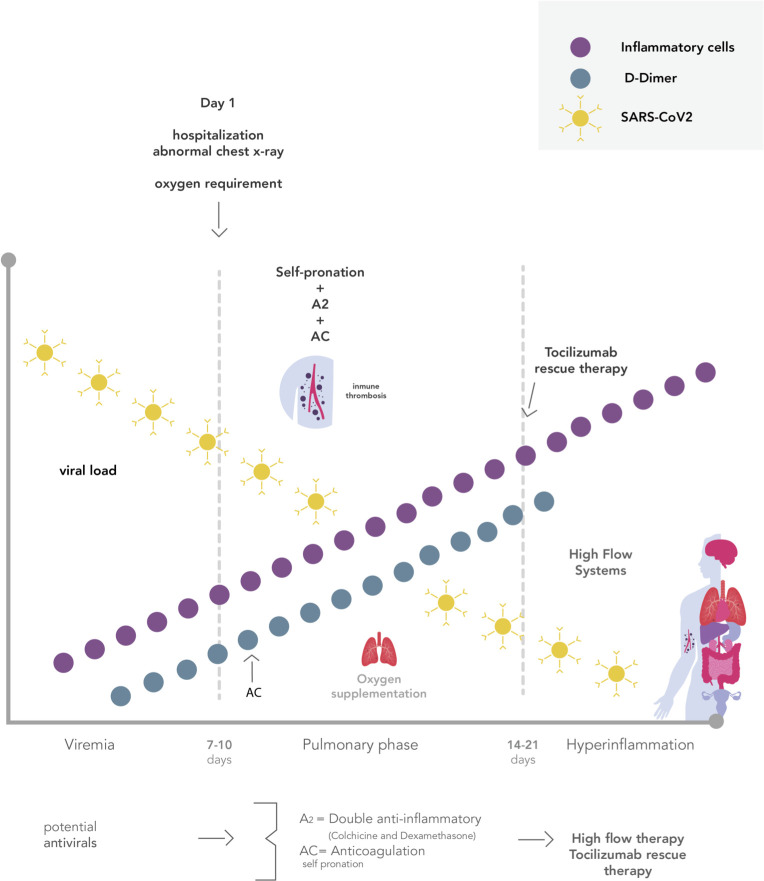
Days following COVID-19 clinical phases.*A2: double anti-inflammatory, AC: anticoagulation. MMA used in the hospital phases of COVID-19, illustrating timing is essential.